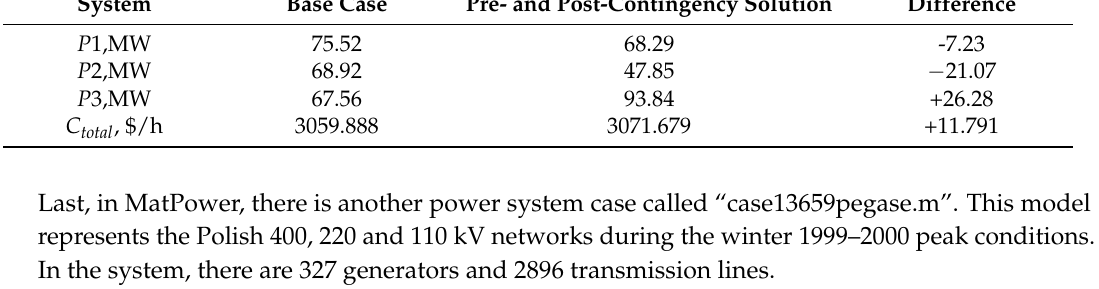
Table 4. Pre- and post-contingency solutions: 6-bus power